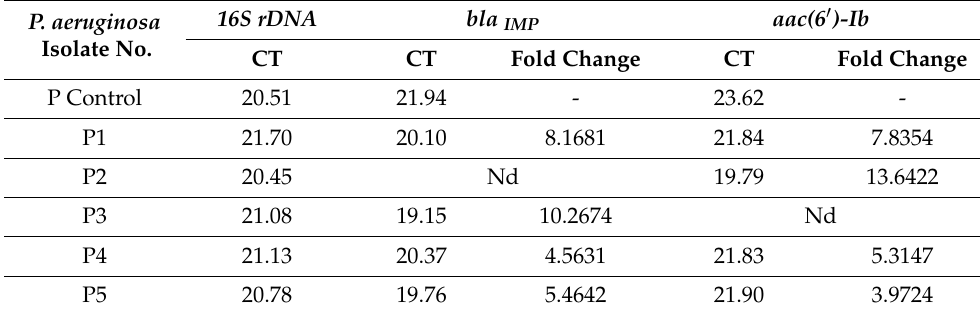
Table 5. Gene expression for resistant P. aeruginosa after treatment.